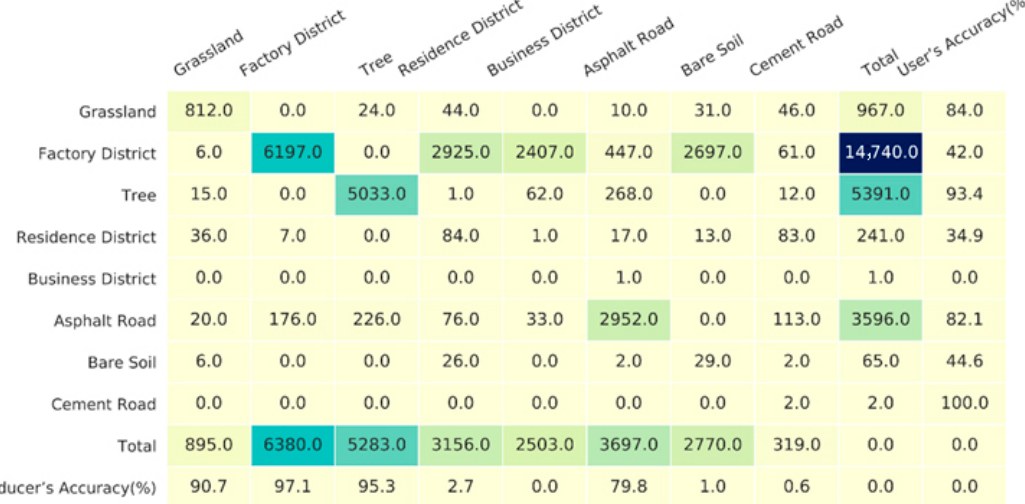
Figure 4. Kappa values of the classification results derived when a single-angle image was used as the input data. The red line represents the average of every single-angle kappa value of the classification results.